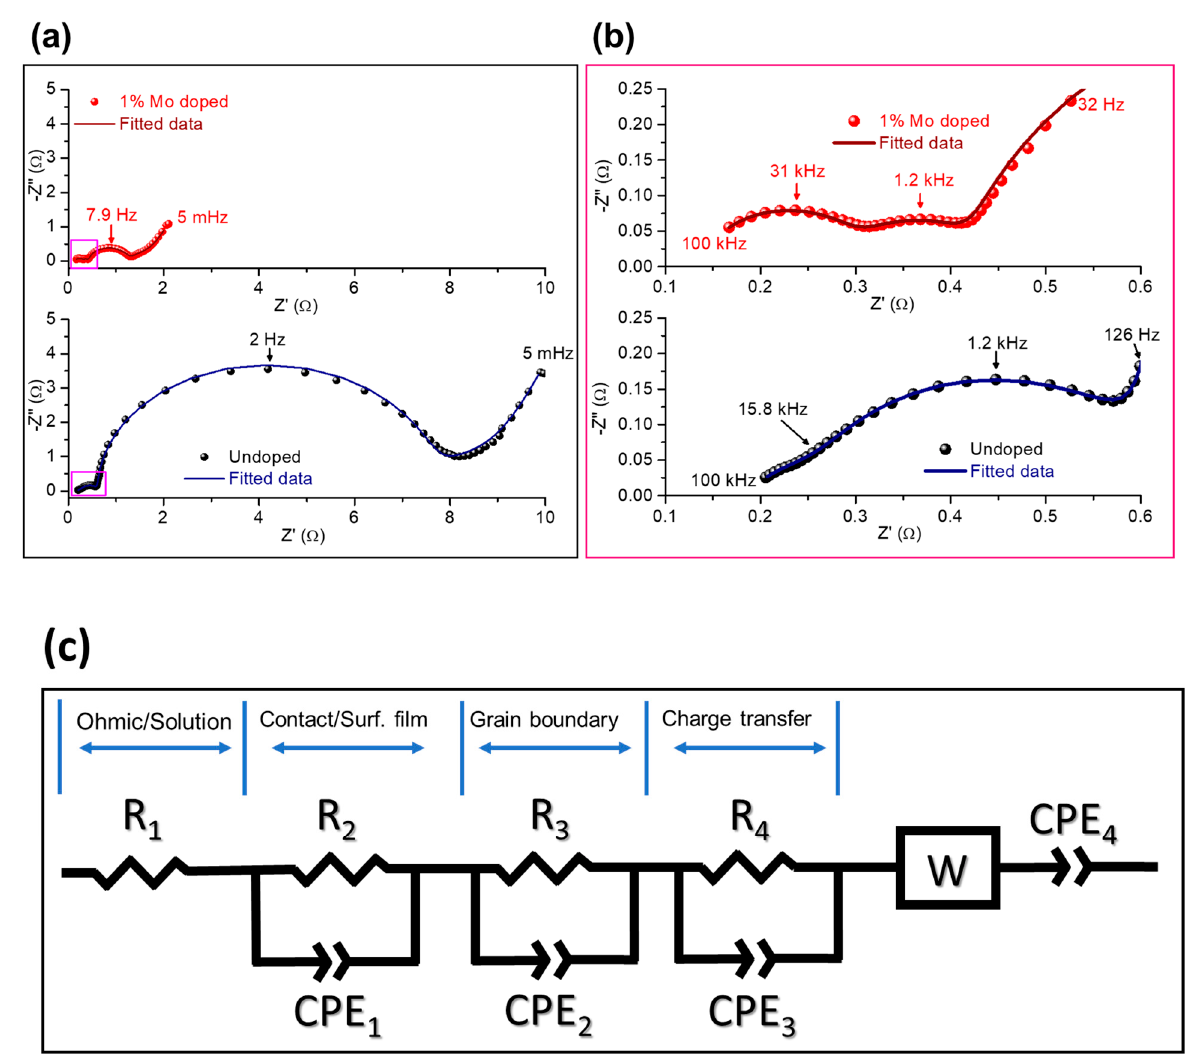
Figure 10. Impedance spectra of NCM85 undoped and Mo-doped electrodes measured during charging at 4.0 V, 30 ◦ C in three-electrode pouch-type cells with the Li-reference electrodes (as described in the text). Symbols are experimental points and solid lines are fitted data: ( a ) full scale spectra and ( b ) an enlarged view of the high-to-medium frequency regions of the spectra marked with the rose color rectangles. ( c ) An equivalent circuit model of the impedance of NCM85 electrodes.